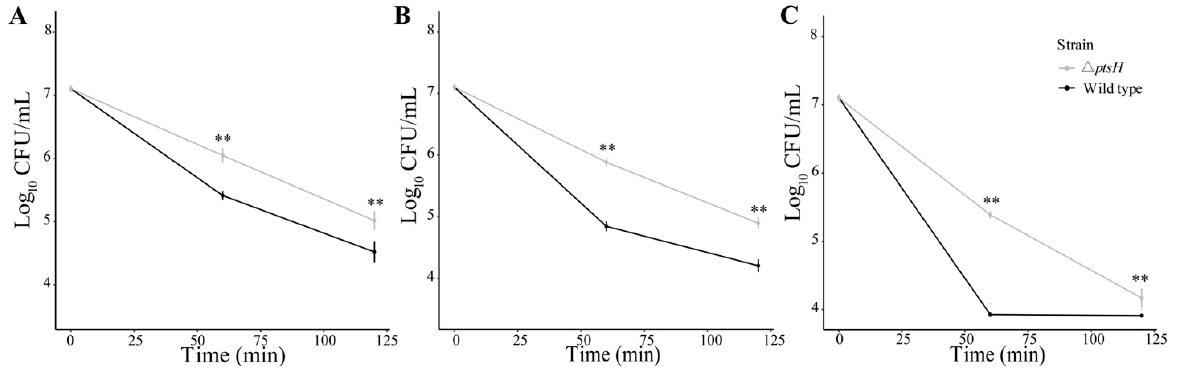
Figure 4. The survival of the WT strain and Δ ptsH mutant under 10% NaCl ( A ), 15% NaCl ( B ), and 20% NaCl ( C ). ** p < 0.01 compared to the WT strain.